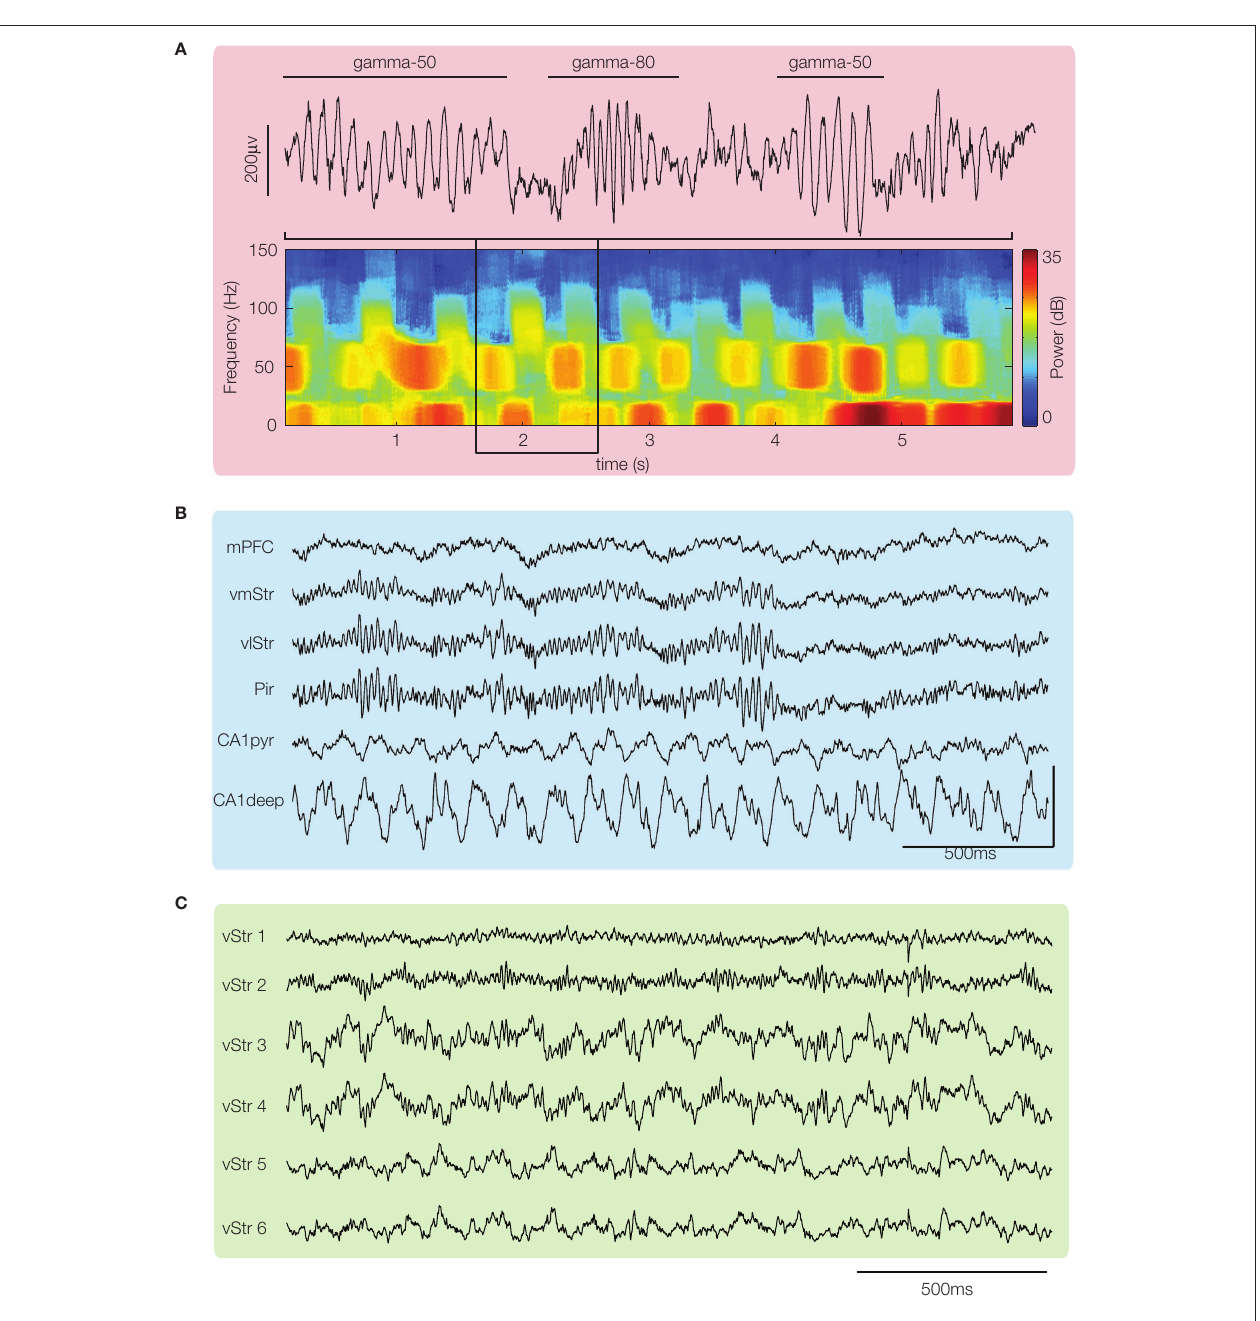
shows that LFP gamma oscillations can be nearly identical in both. Figure adapted from Berke (2005, 2009; vmStr is ventromedial striatum, vlStr ventrolateral). (C) Simultaneously recorded local field potential (LFP) traces from sites within ventral striatum suggest that gamma power can show heterogeneity between different recording sites. Traces taken from the data set in Kalenscher et al.